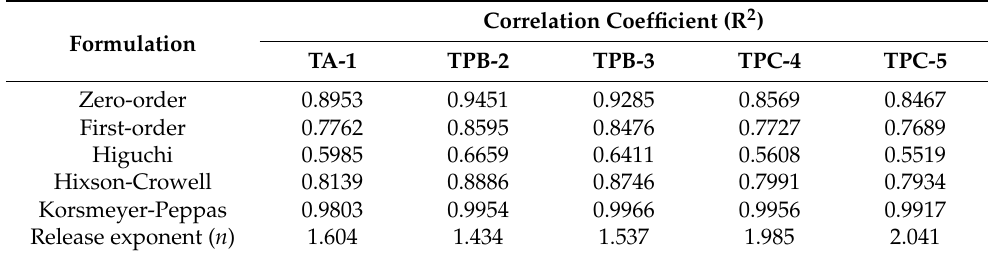
Table 5. Kinetic evaluation of the in vitro drug release data of various TRHC-PAG-alginate microspheres.